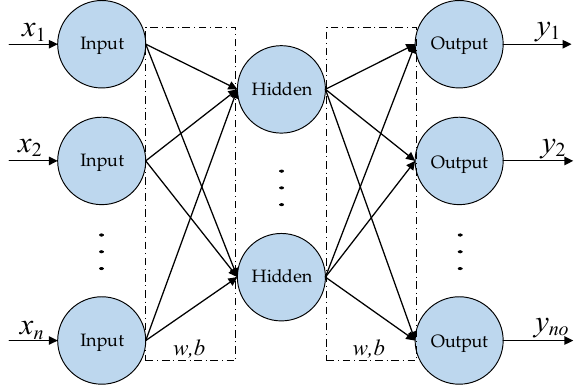
Figure 5. The structure of a conventional three-layer BPNN.